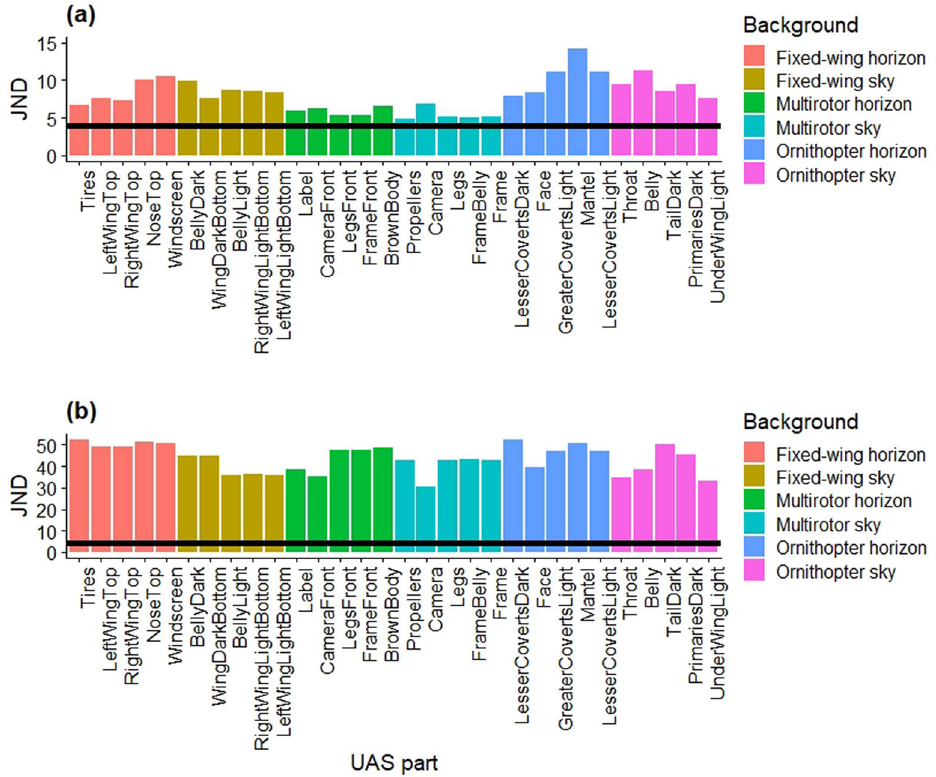
Figure 3. Chromatic ( a ) and achromatic ( b ) contrast values for five of the largest parts of three UAS platforms under party cloudy ambient light conditions, using visual system properties of general violet sensitive avian species for two different backgrounds (sky and horizon). Just noticeable differences (JND, black horizontal bar) > 4 indicates the object can be distinguished from the visual background. The fixed-wing and multirotor were painted to match the countershading of the